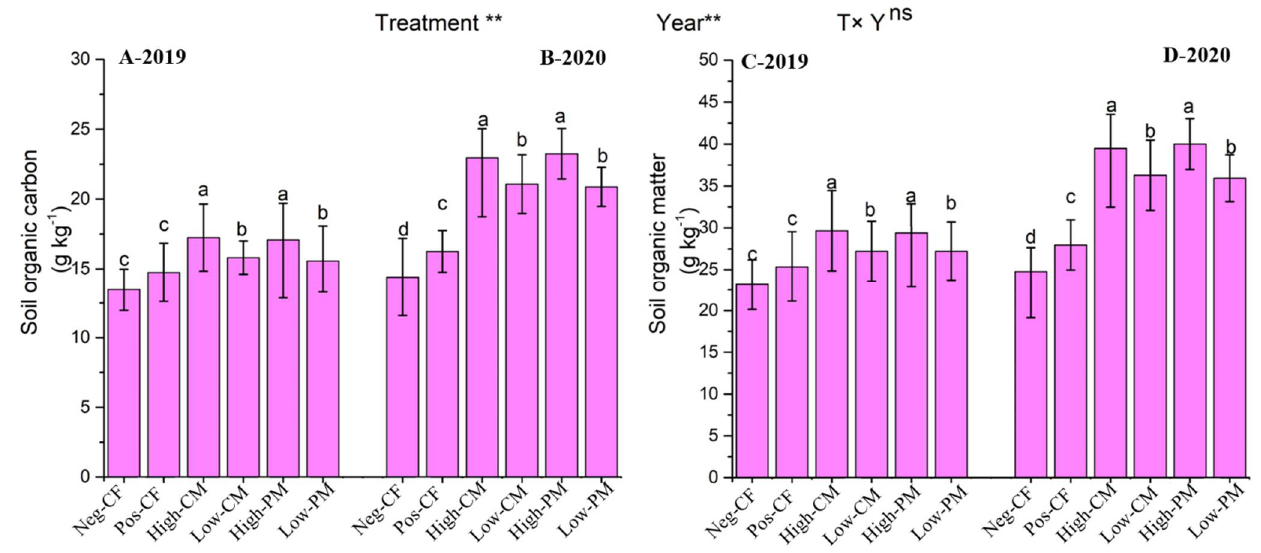
Figure 2. Changes in soil organic carbon in the year 2019 ( A ) and 2020 ( B ) and soil organic matter in the year 2019 ( C ) and 2020 ( D ) as affected by integrated manure and chemical N fertilizer application. Means sharing the same letter within a category are not significantly different according to Tukey’s HSD test at p < 0.05. ** = significant at 1%, and ns = non-significant. Note: Neg-CF, no N fertilizer; Pos-CF, 100% chemical fertilizer (CF); High-CM, 60% cattle manure (CM) + 40% (CF); Low-CM, 30% CF + 70% CF; High-PM, 60% poultry manure (PM) + 40% CF; Low-PM, 30%PM + 70% CF.